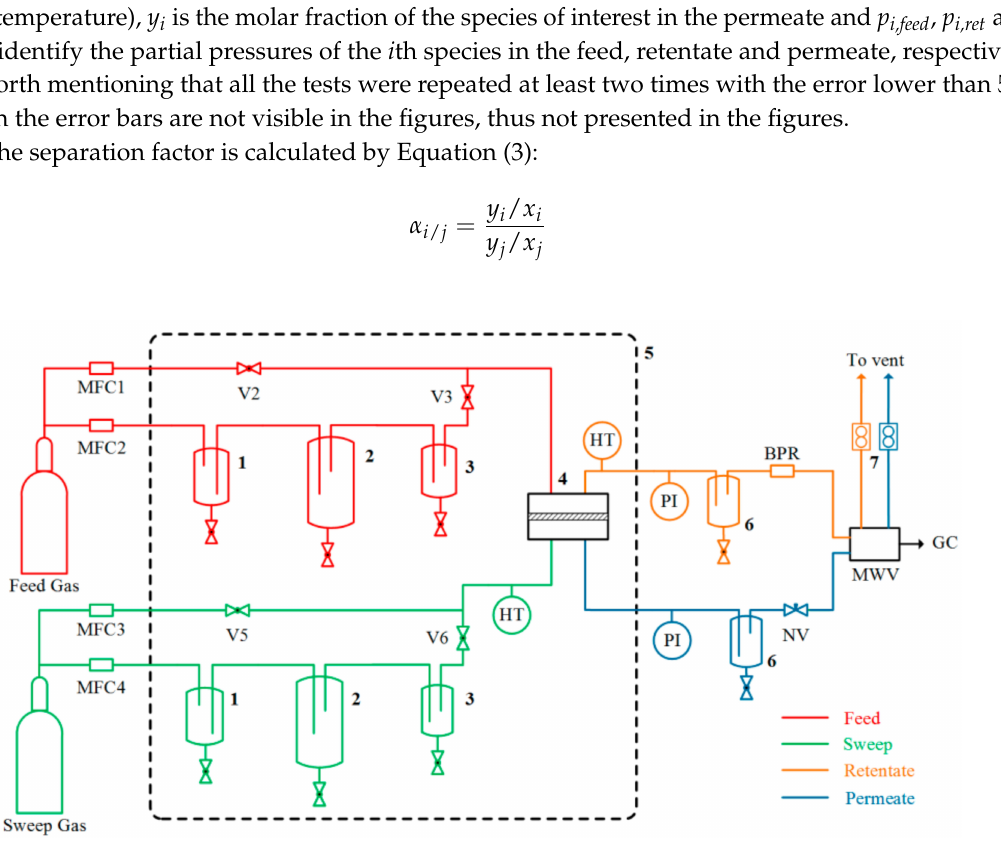
Figure 3. Mixed-gas permeation setup ( 1 : MFC-safety trap; 2 : Humidifier; 3 : Droplets trap; 4 : Membrane module; 5 : Heated cabinet; 6 : Water knockout; 7 : Bubble flow meters; MFC : Mass flow controller; NV : Needle valve; BPR : Back-pressure regulator; PI : Pressure indicator; HT : Humidity and temperature sensor; MWV : Multi-way valve; GC : Gas